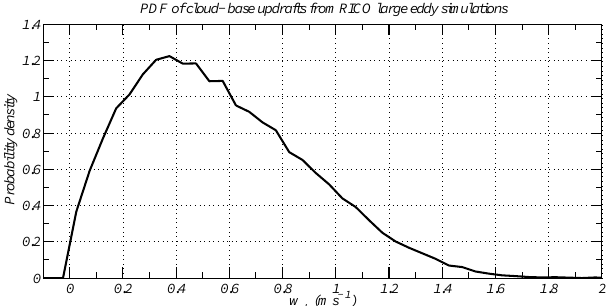
Fig. 10. The PDF of updraft velocities derived from RICO. This is Fig.10. ThePDFofupdraftvelocitiesderivedfromRICO.Thisispresentedasaprobabilitydensity, ∞ presented as a probability density, where R where 0 Pdw cb = 1 . R Figure 11shows cumulative frequencies ( n = 10 5 ) of the activated fractionfor the parcel 315 modelruns;theFountoukisandNenesimplementationoftheschemeandtheAbdul-Razzak et al. implementation. The figure shows that addition of semi-volatile co-condensation broadens the range of activated fractions and importantly leads to a much higher frequency at higher activated fractions (as noted by the fact that the cumulative frequency is close to unity at lower activated fractions). 320